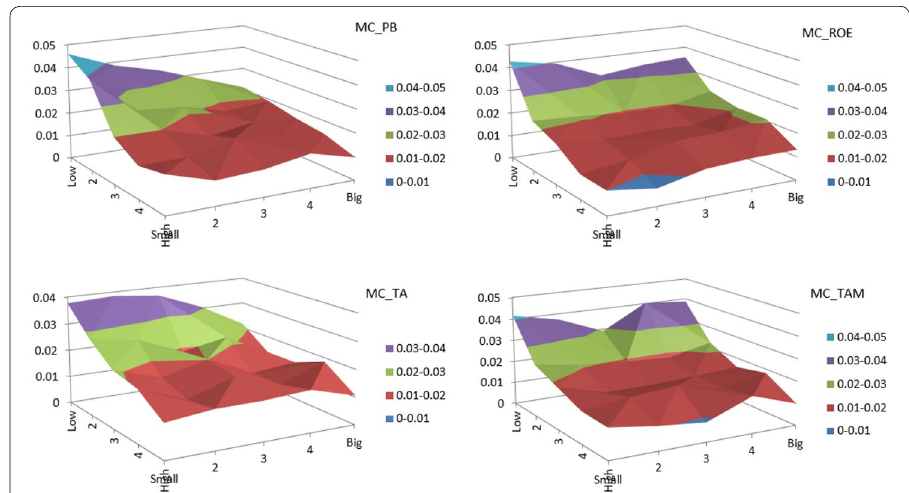
Fig. 2 Visual 3D surface images for 25 portfolios mean returns formed on MC_PB, MC_ROE, MC_TA and